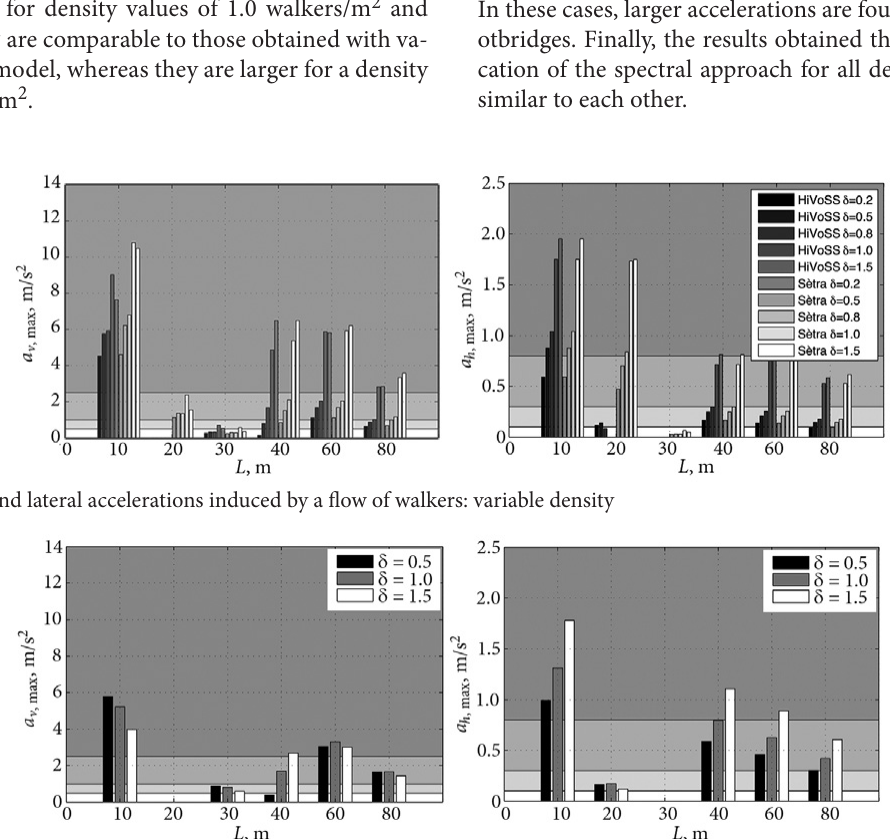
Fig. 10. Vertical and lateral accelerations induced by a flow of walkers: spectral approach of